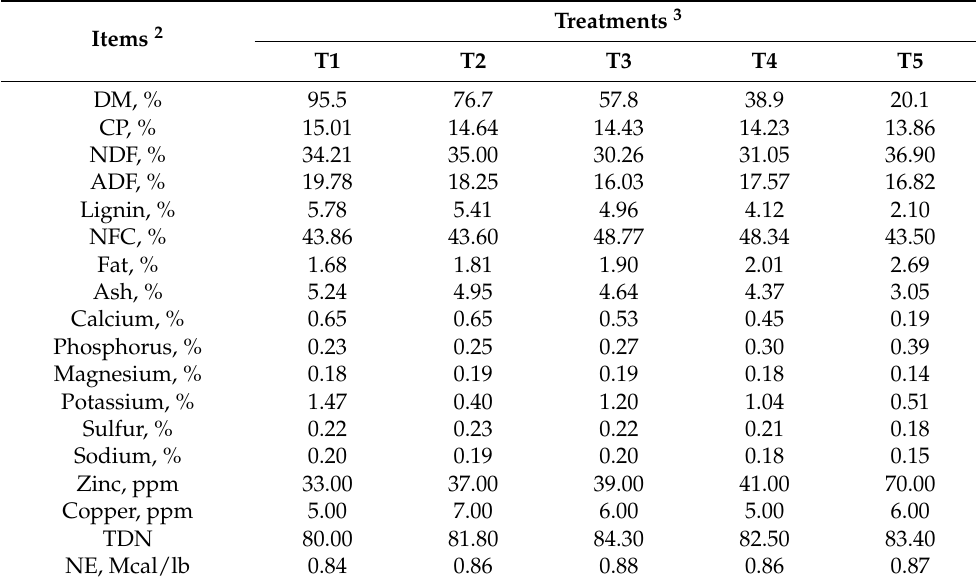
Table 1. Chemical composition of the diets fed growing lambs on a DM basis 1